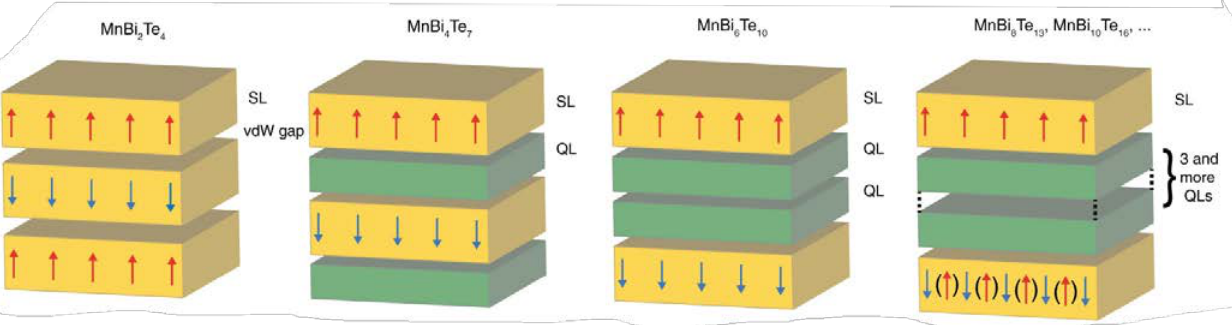
Figure 10. Multilayer view of magnetic insulator MnBi 2 Te 4 family. (SLs-Septuple layer, QL-Quintuple layer). Red arrows and green arrows represent up-spin and down-spin respectively. (© The Author(s) 2020) [94].